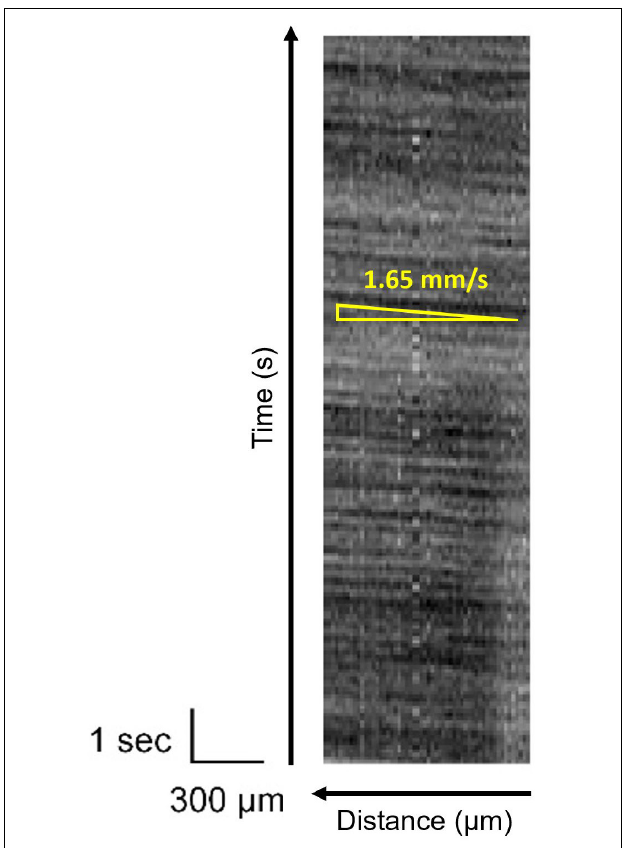
FIGURE 12 | Line scan image of the blood vessel indicated in Figure 11C . The movement of red blood cells is shown as dark